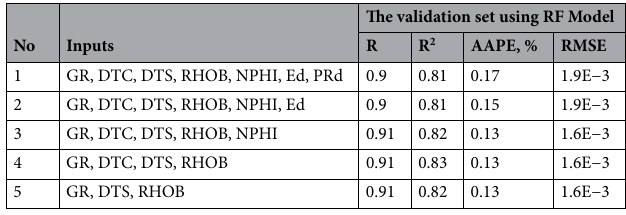
Table 2. Performance of different sets of inputs.